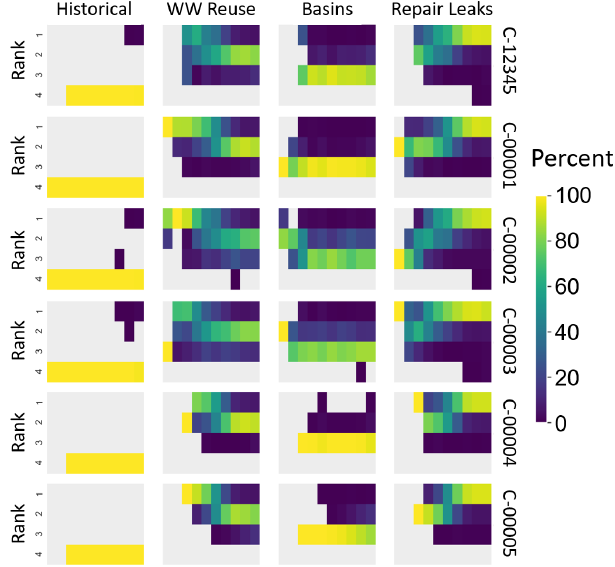
Figure 9. Alternative performance in the water quality objective, shown as heat maps of the count of parameter sets, where the alternative performance was ranked from (1) best to (4) worst. Within each heat map, the rows are the rank, and the columns are the parameter value from minimum (1 . 00 × 10 − 1 ) to maximum (1 . 00 × 10 2 ). The subplots are organized by the observation clus- ter used for the behavioral parameter set selection (rows) and the aquifer management alternatives (columns).